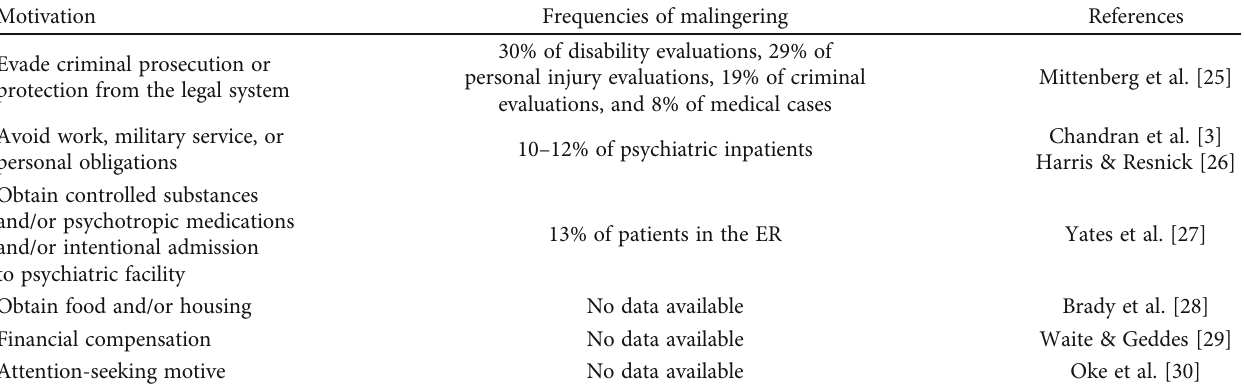
Table 1: Types of secondary gain in the malingering of psychotic